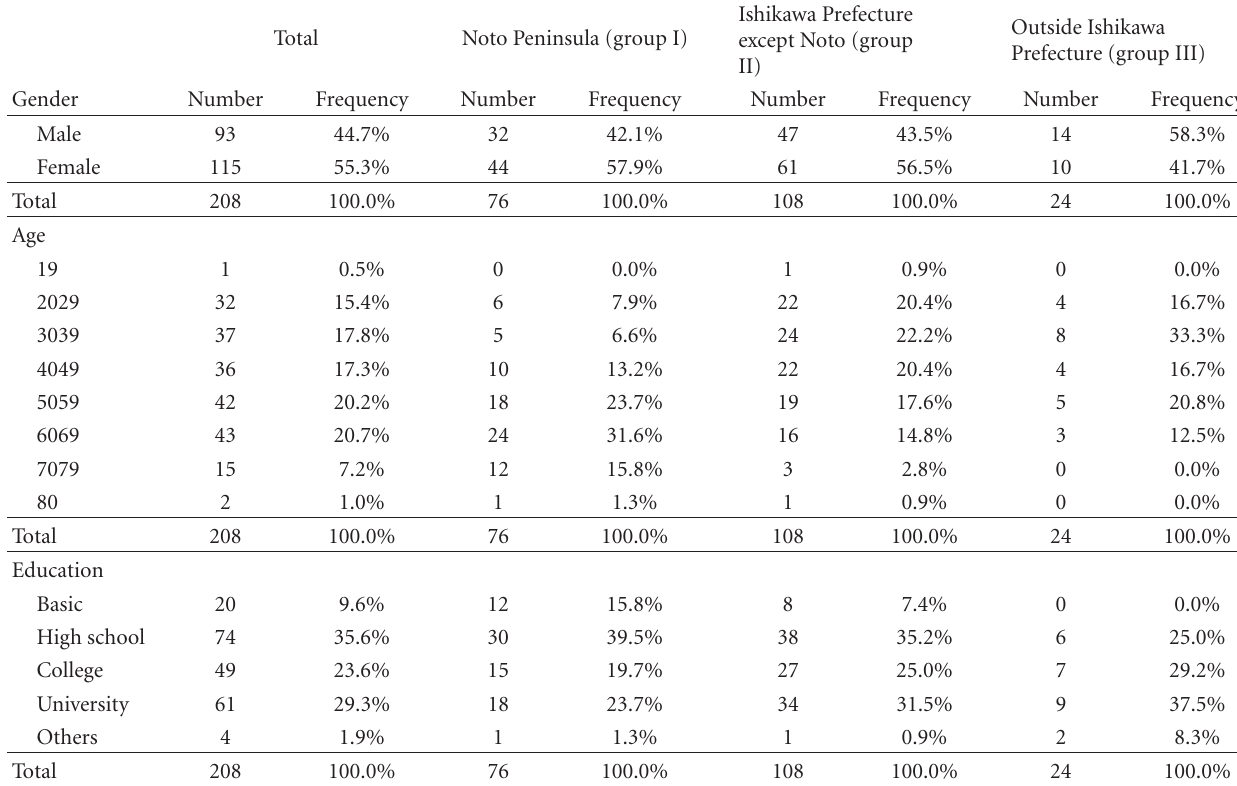
Table 3: Profile of